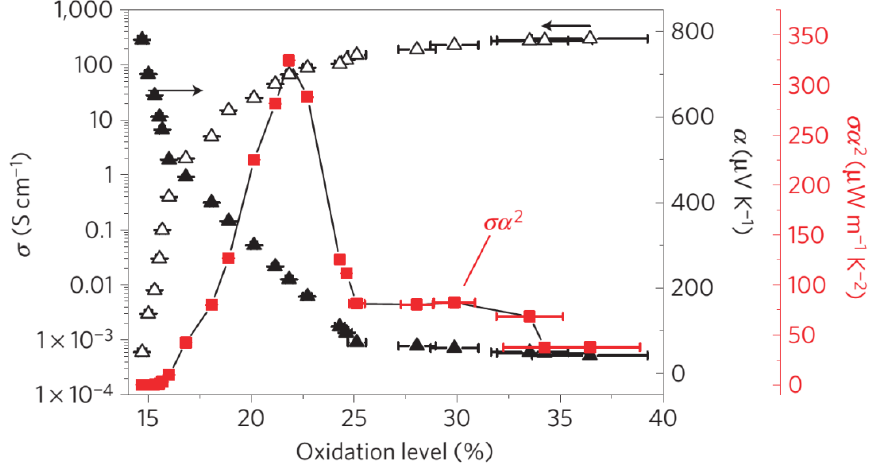
Figure 4. Seebeck coefficient (filled triangles), electrical conductivity (open triangles) and corresponding power factor (red squares) versus oxidation level of the PEDOT/tos films. Reproduced with permission from [46]. Copyright 2011 Nature Publishing Group.